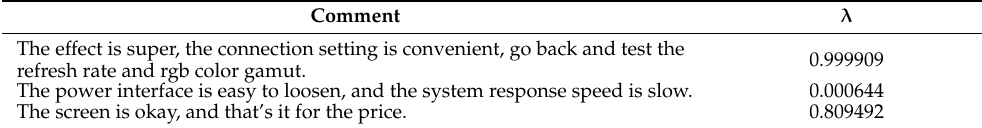
Table 2. Sentiment analysis of product evaluation.